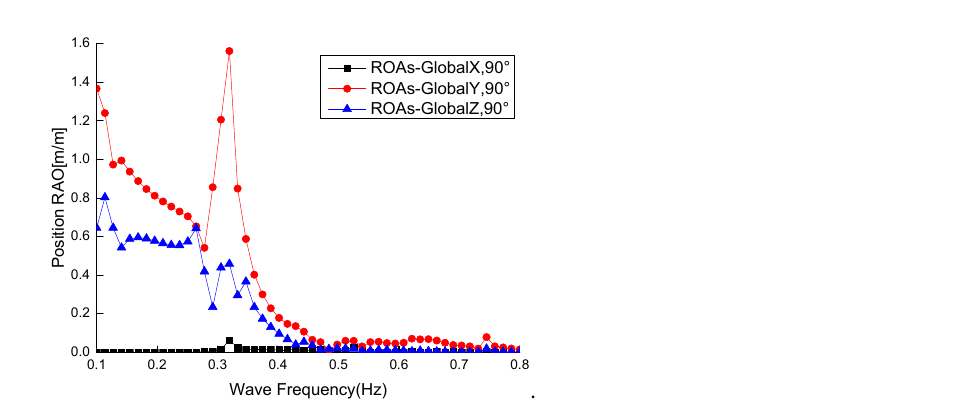
Figure 4. Likewise, the value of the RAO in the RX, RY, and RZ directions varied with the wave frequency, which is shown in Figure 5.